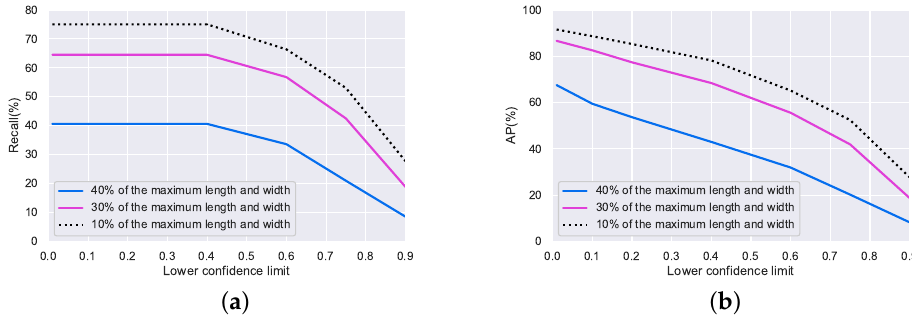
Figure 13. Recall and AP index of the model under different adversarial patch sizes; ( a ) Recall rate under different adversarial patch sizes; ( b ) AP under different adversarial patch